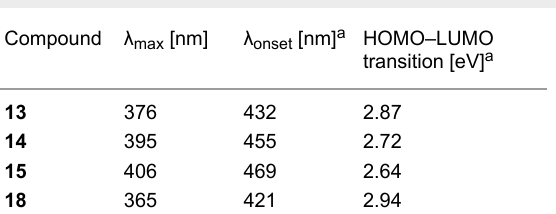
Table 1: Absorption spectral parameters of investigated donor–acceptor–donor